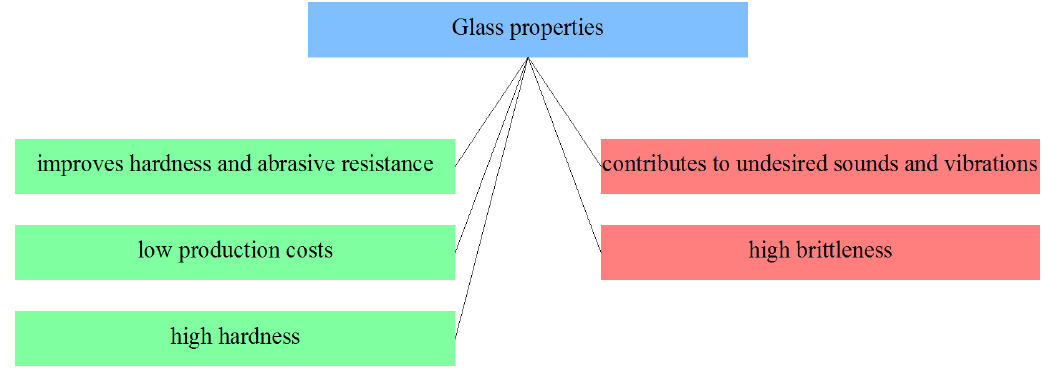
Figure 12: Selected glass properties from the point of view of applicability in friction materials